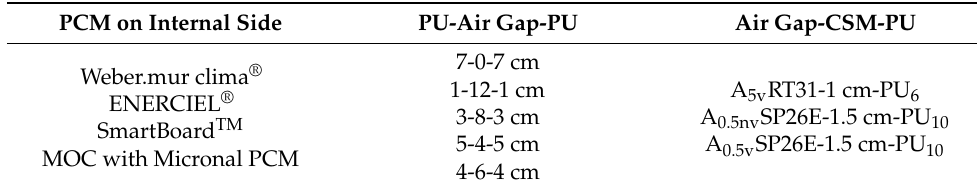
Table 5. Solutions for parametric analysis with PCM on both sides.